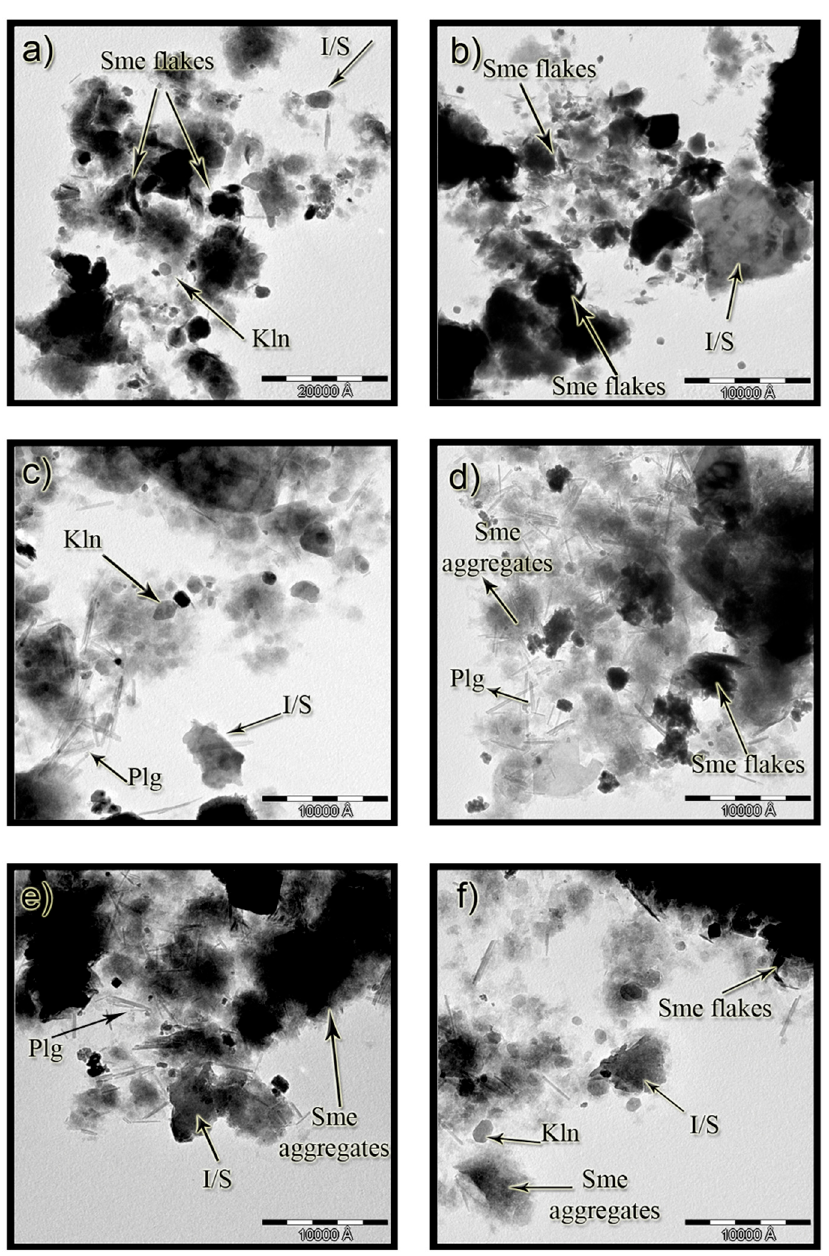
Figure 3. TEM micrographs of the major phases present. Sme, Smectite; Kln, Kaolinite; Plg, Palygorskite; I/S, Illite–smectite interstratified. Samples: ( a ) M8 58-62; ( b ) M12 50-54; ( c ) C9 84-85; ( d ) C8 23-24; ( e ) M25 34-38; and ( f ) A2 48-50.